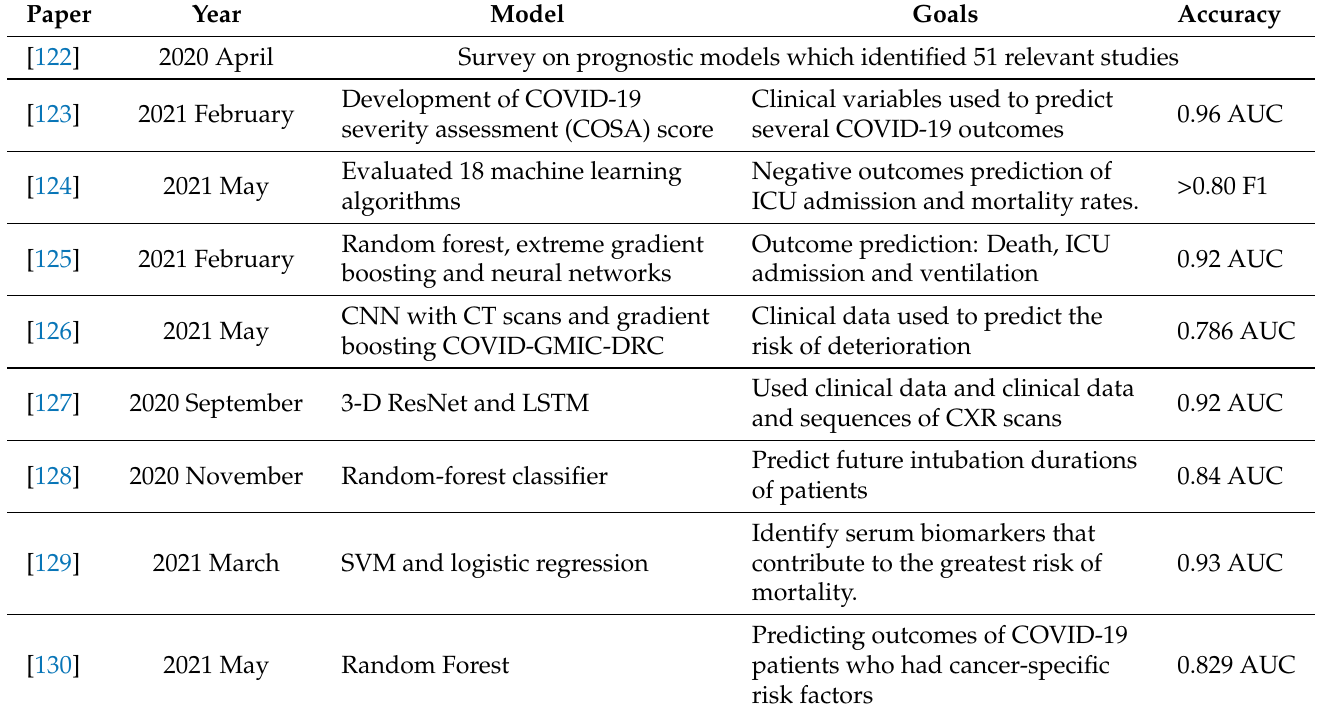
Table 5. Machine learning approach summarized for developing prognostic models in